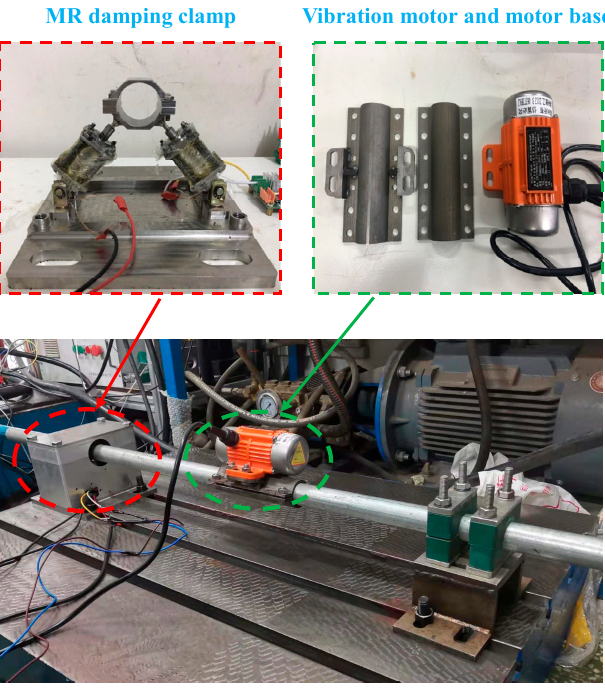
Figure 11. Experiment device structure.